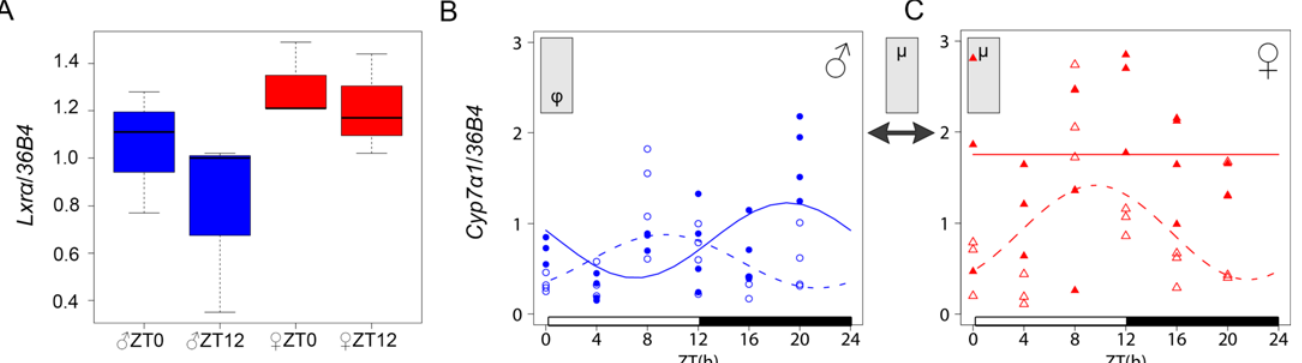
Fig 3. Analysis of Lxr α and Cyp7 α 1 in liver. Lxr α mRNA expression determined at ZT0 and ZT 12 in WT males and females using qRT-PCR (A). Diurnal mRNA expression of liver Cyp7 α 1 was compared in males (B) and females (C) using qRT-PCR in WT (plain line) and Lxr α -/- mice (dashed line). For each time point, 3 – 4 mice were used. For the Cyp7 α 1 analysis, cosinor-based non-linear regression was used for curve fitting. The ZT0 time point is double plotted for visualization purposes. Expression data were normalized to the constitutively expressed 36B4 mRNA. The white and black bars represent the light and dark phases, respectively. Statistically significant differences in cosine fitting parameters (p < 0.05) between wild type and Lxr α -/- mice or between male and female of the same genotype is indicated in the grey box at the top of the corresponding graph or between graphs (WT: plain arrow, Lxr α -/- : dashed arrow). µ , α and φ indicate a difference in mean level, amplitude and acrophase, respectively.